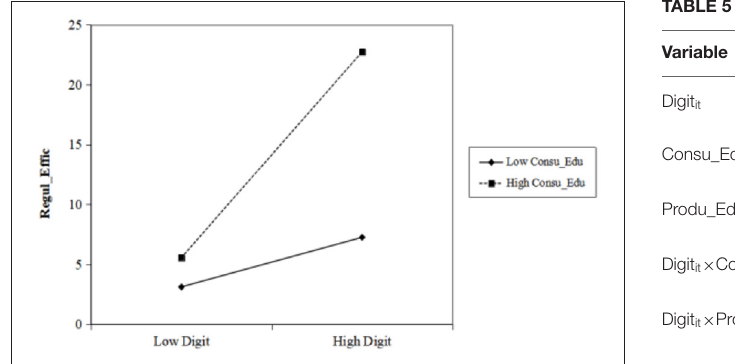
FIGURE 1 | Adjustment effect of consumer knowledge level.